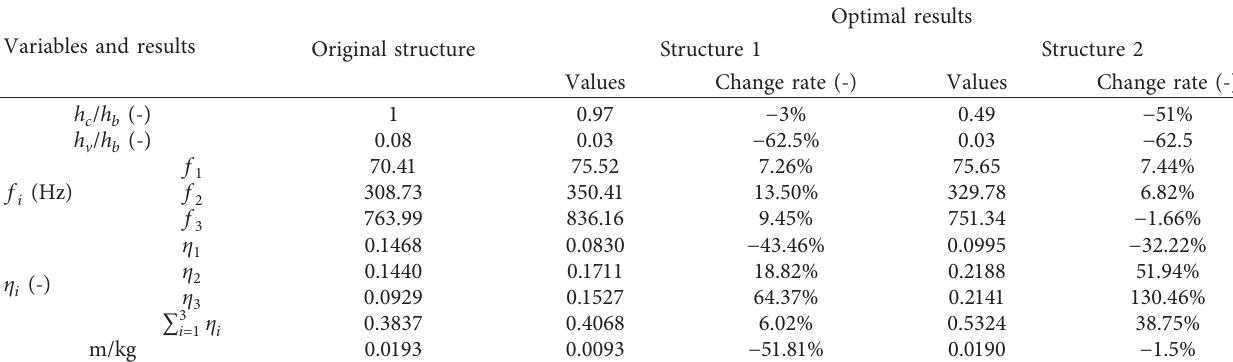
Table 3: The optimal results.